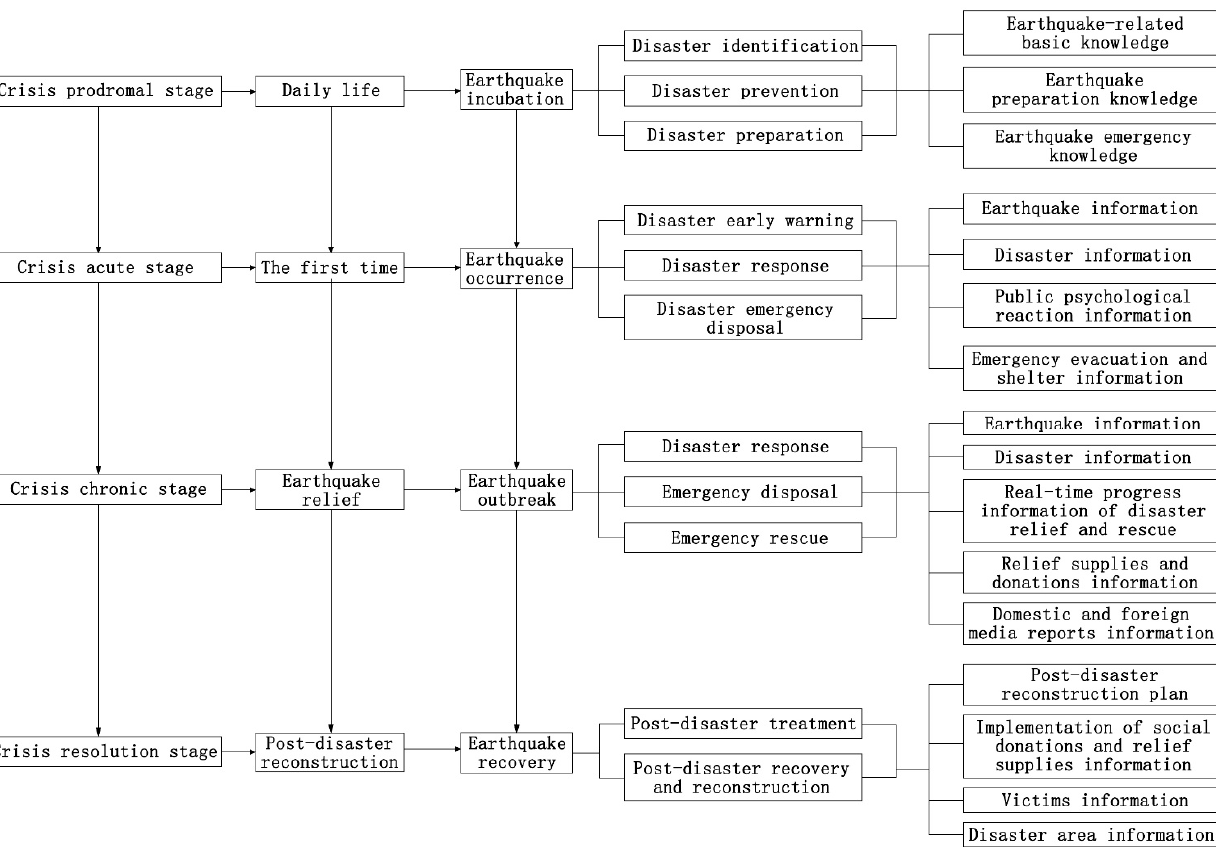
Figure 10. Main information composition in the different stages of an earthquake disaster.